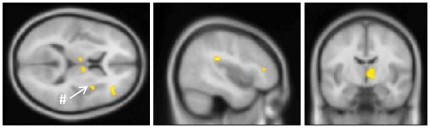
TGI-stimulation versus neutral baseline.Crosshair-position: x = 44 mm, y = −8 mm, z = 10 mm. A large cluster of activation was observed in the right thalamus, partially extending over into the left thalamic region. Right-sided fronto-parietal activation was also found. #: the post-hoc contrast with less stringent cluster-extent criteria (cluster-extent≥20 voxels instead of 40) revealed an additional activation in the right mid/anterior insula. See also Table 2.